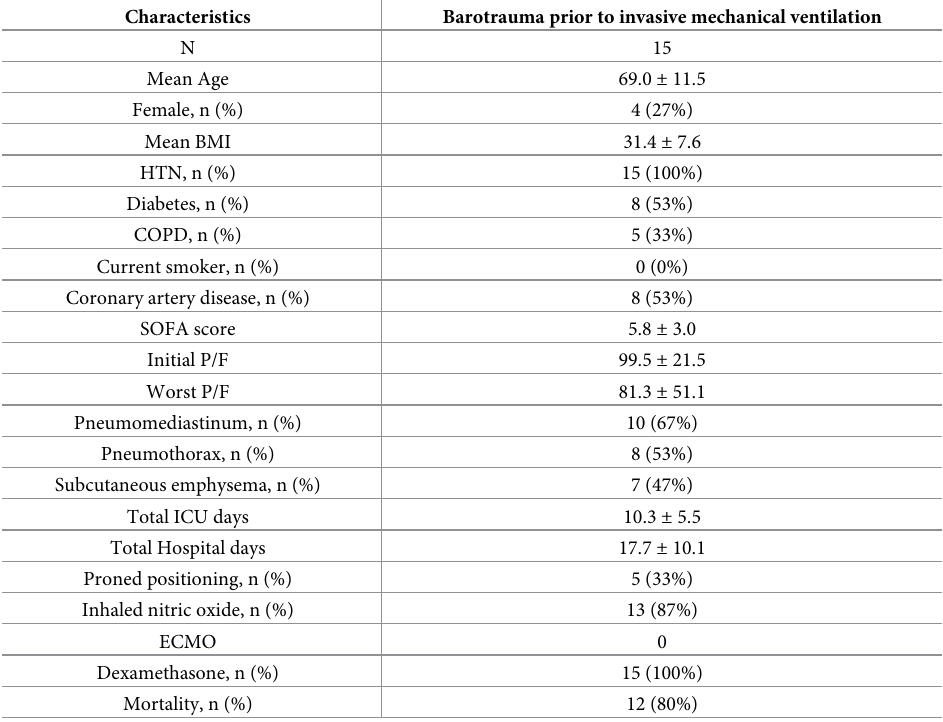
Table 4. Baseline characteristics and outcomes of patients with COVID-19 with barotrauma prior to intubation and mechanical